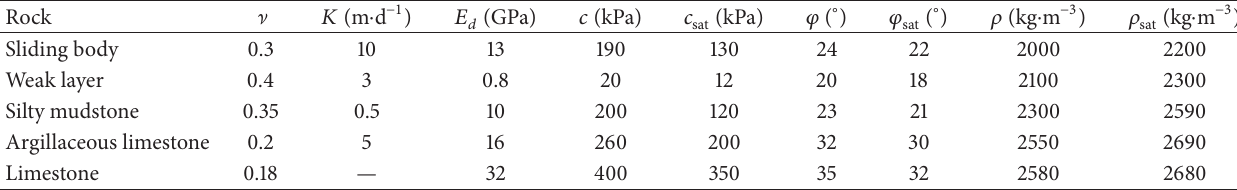
Table 2: Physical and mechanical parameters of numerical model.